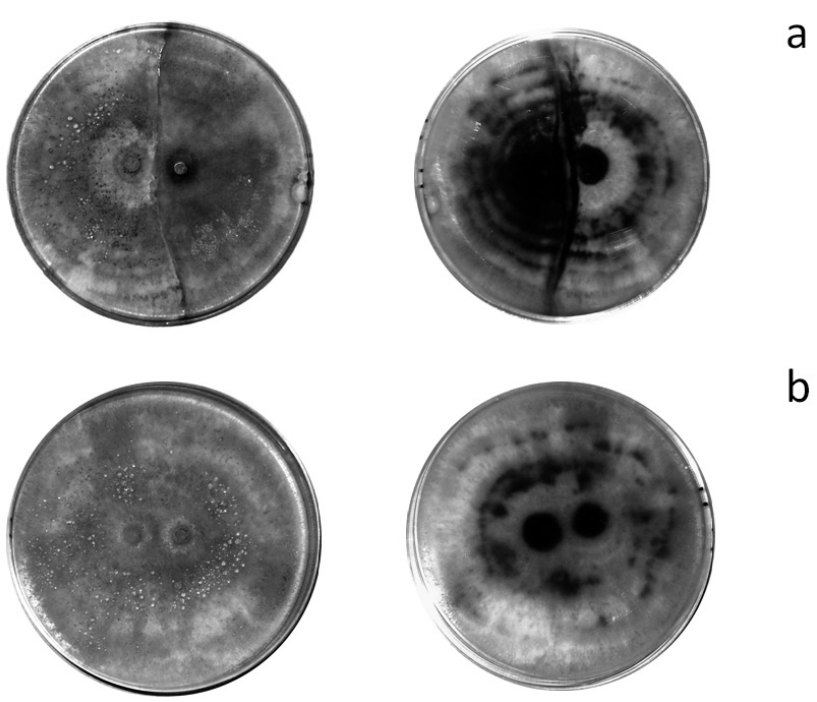
Figure 3. Examples of somatically incompatible (a: A.3.1 vs. A.3.2) and compatible (b: A.3.1 vs. B.4.1) reactions be- tween paired isolates of Inonotus rickii